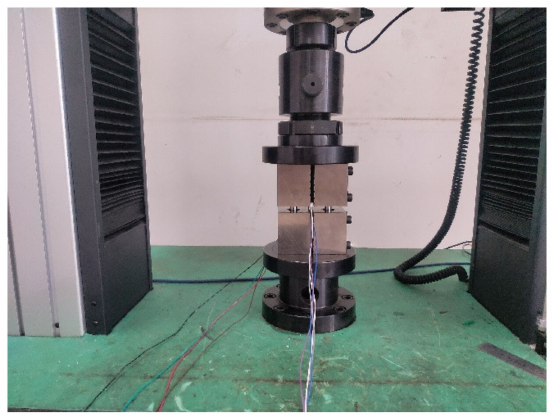
Figure 4. WDWE200D compression test